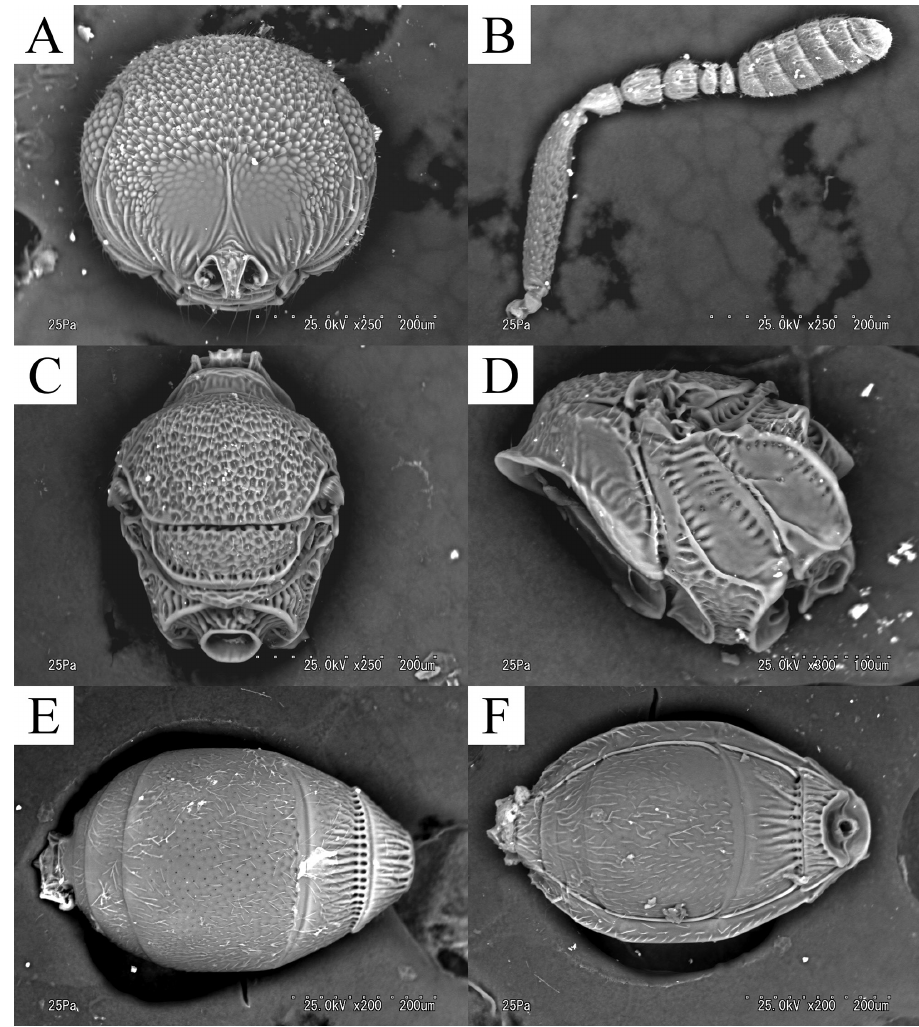
Figure 5. Trimorus granulatus sp. n., female. A head, frontal view B Antennae C mesosoma, dorsal view D mesosoma, lateral view E metasoma, dorsal view F metasoma, ventral view.